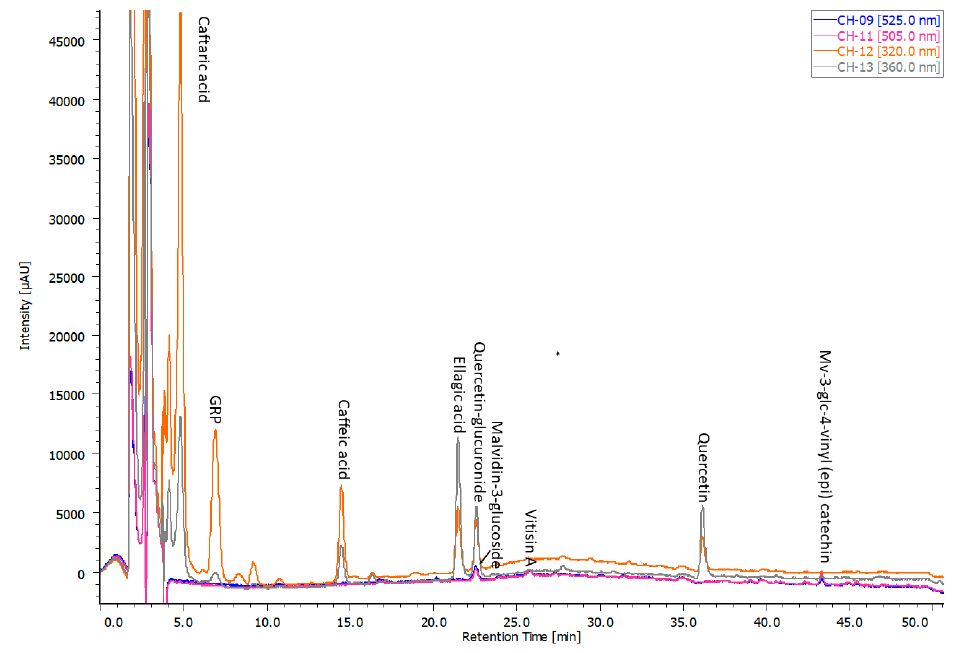
Figure 1. HPLC ‐ DAD chromatogram of phenolic compounds adsorbed onto chitosan surface. Figure 1. HPLC-DAD chromatogram of phenolic compounds adsorbed onto chitosan